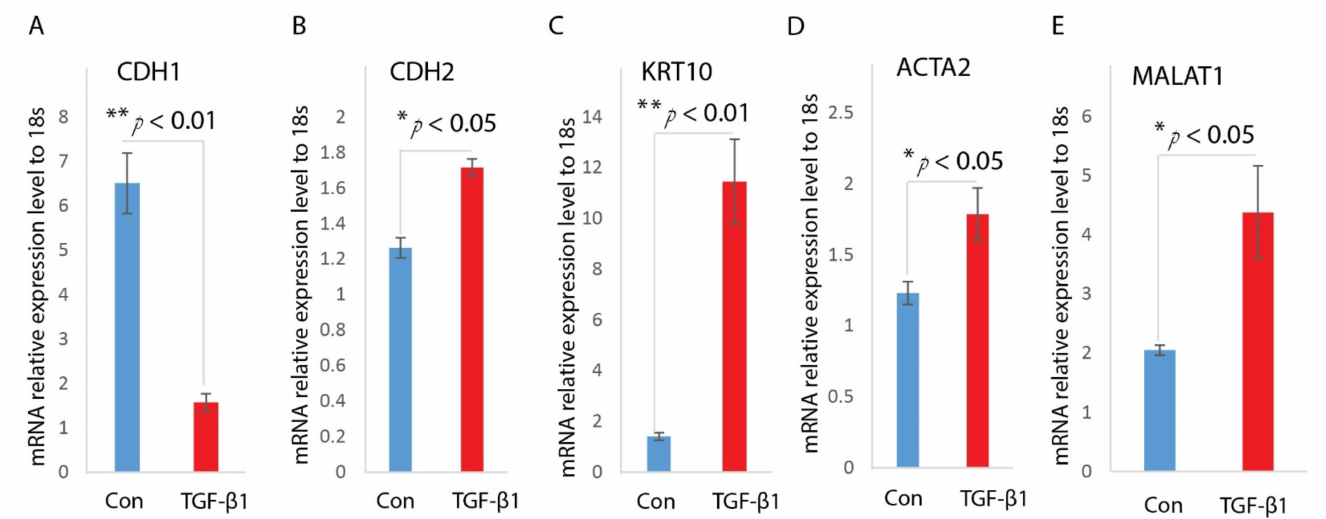
Figure 2. TGF- β 1 induces EMT and MALAT1 expression in HaCaT cells. HaCaT cells were treated with TGF- β 1(2 ng/mL) after overnight serum starvation. RNAs were isolated and the expressions of CDH1 ( A ), CDH2 ( B ), KRT10 ( C ), and ACTA2 ( D ) were determined by Realtime qPCR. n = 3; mean ± SD; * p < 0.05, ** p < 0.01 compared with untreated HaCaT cells. ( E ) Levels of MALAT1 in TGF- β 1-treated HaCaT cells were determined by Realtime qPCR. 18s was used as an internal control. n = 3; mean ± SD; * p < 0.05, ** p < 0.01 compared with untreated HaCaT